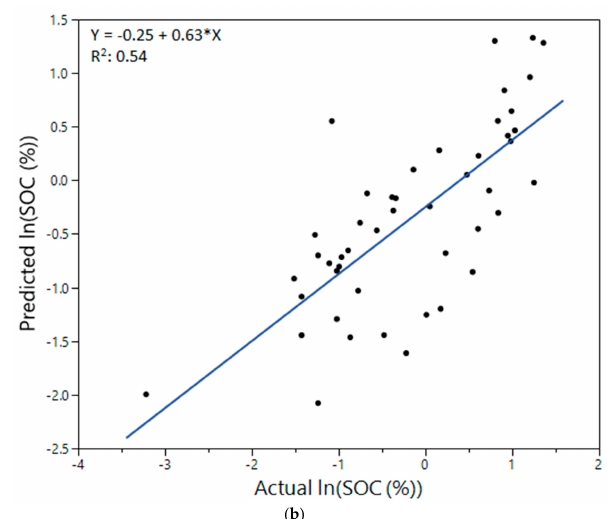
Figure 2. Plots of predicted lnSOC (%) content versus actual lnSOC (%) content for validation data sets for dry soil samples of all soil orders using ( a ) models which included depth and color variables ( p -value < 0.001), and ( b ) models which included only color variables as predictors ( p -value < 0.001). The lnTN (%) prediction model, which included depth and color variables, indicated that depth, L* , and b* were significant predictors of lnTN (%) (Table 4). Cross-validation resulted in a MSPE of 0.18 ( R 2 = 0.71; Figure 3a, Table 4). The lnTN (%) prediction models, which included only color variables, indicated that L* and b* were both significant predictors of lnTN (%) (Table 4). Cross- validation resulted in a MSPE of 0.248 ( R 2 = 0.61; Figure 3b, Table 4). Depth accounts for more variability in lnTN (%) when included in the model, resulting in a larger R 2 value. Interestingly, b* is a significant predictor of lnTN (%), but not for lnSOC (%) for all soil samples combined. Further investigation into the relationship between how blue or yellow ( b* ) a soil may appear and TN content may help to develop stronger TN prediction models. Table 4. Variable estimates and ANOVA results for final prediction models using depth (cm) and color variables, and color variables alone, to predict lnTN (%).